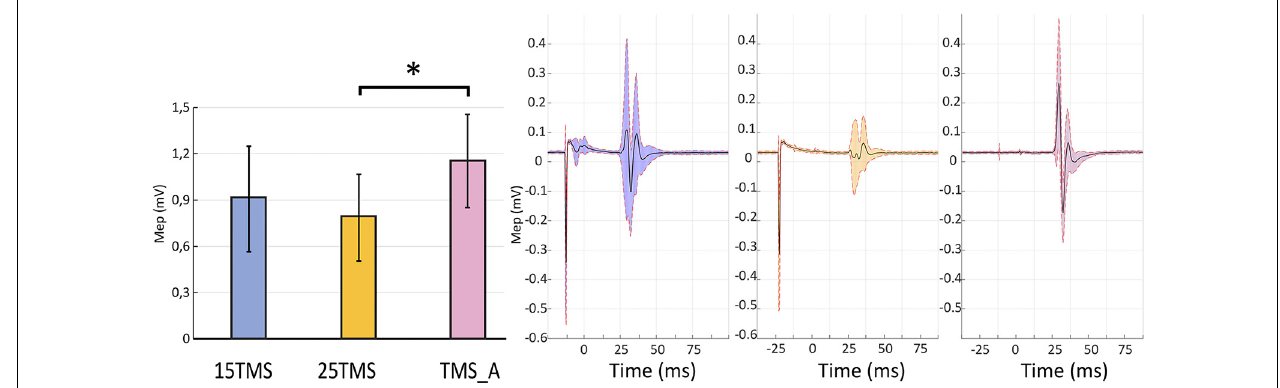
FIGURE 2 | Short-latency afferent inhibition. The left panel presents motor evoked potential (MEP) amplitudes recorded in the three conditions containing TMS stimulations ± SEM: MNS + TMS (15 ms; blue), MNS + TMS (25 ms; yellow), and TMS_A (violet). An asterisk (*) on the top of two bars highlights a significant difference (permutation test; p < 0.05). The right panel shows the average MEP and standard deviation of the opponens pollicis (OP) muscular activity in a representative subject in each of the three conditions containing TMS.